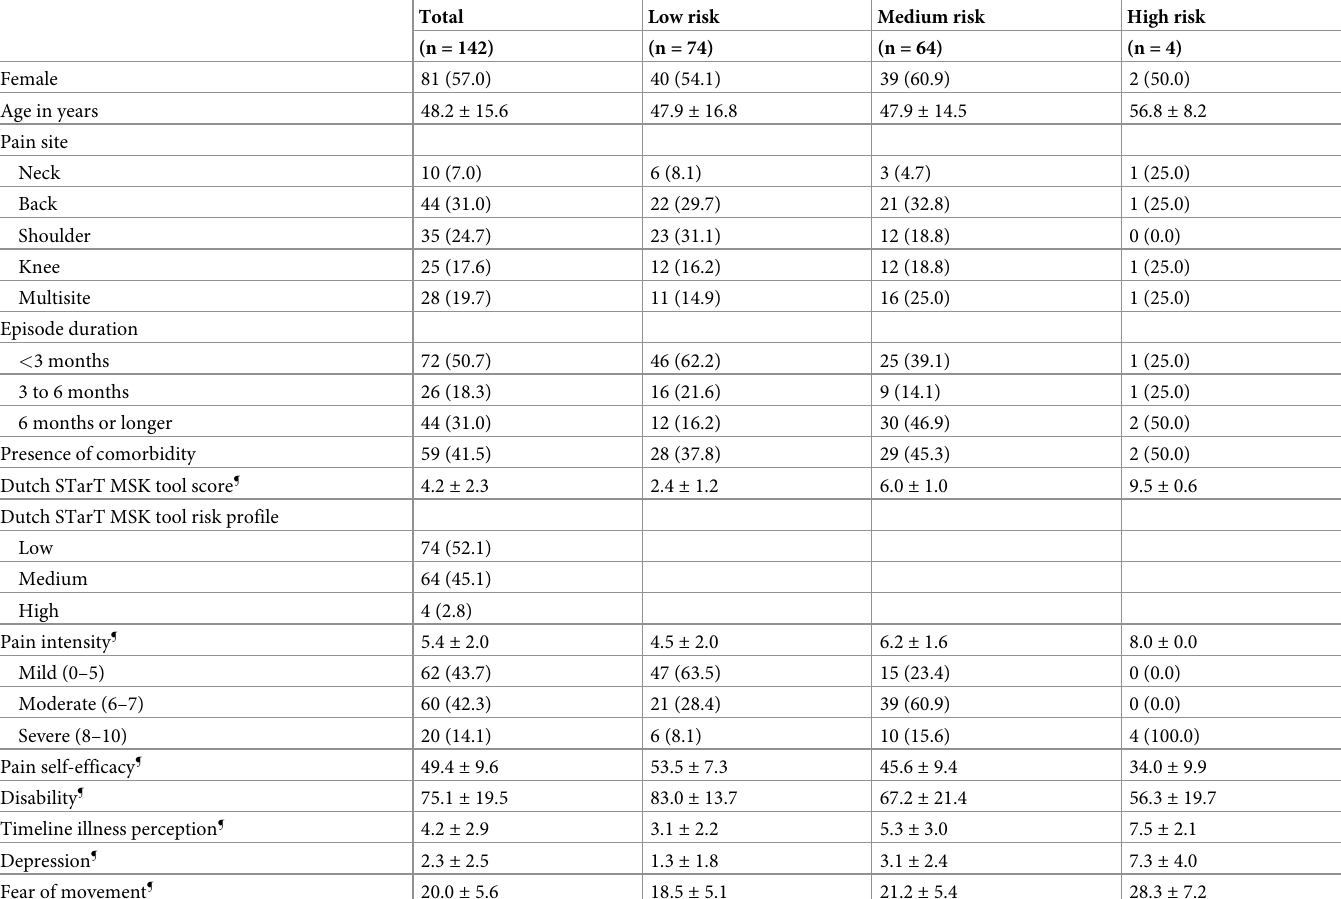
Table 1. Baseline characteristics of the study population � . Total Low risk Medium risk High risk (n = 142) (n = 74) (n =